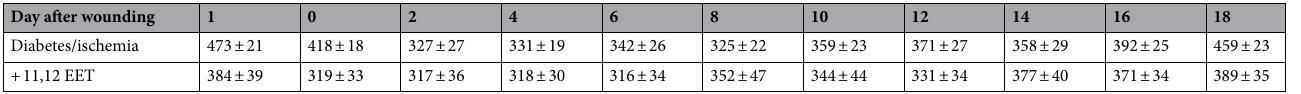
Table 2. Blood glucose measurements in nonfasted diabetes/ischemia animals with and without treatment with 11,12 EET. Blood glucose always exceeded 300 mg/dl. (I = day of